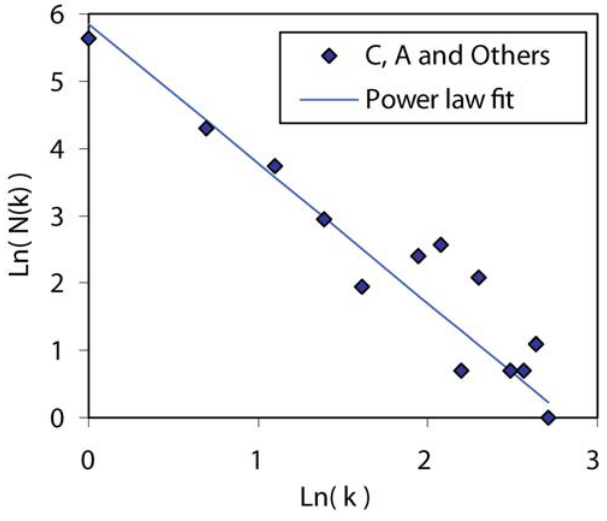
Figure 3. Power law plot of UK-based non-B subtype clusters. Log-log plot of numbers of individuals with k contacts (N(k)) against the number of contacts (k). Individuals are assumed to be in contact within the clusters only if the time to the most recent common ancestor of their virus sequences is less than or equal to 5 years. The best fit to a power law (straight line in log-log space) has R 2 =0.95 (95% CI: 0.84– 0.99), p , 10 2 6 , and shape parameter (negative gradient) a =2.1.